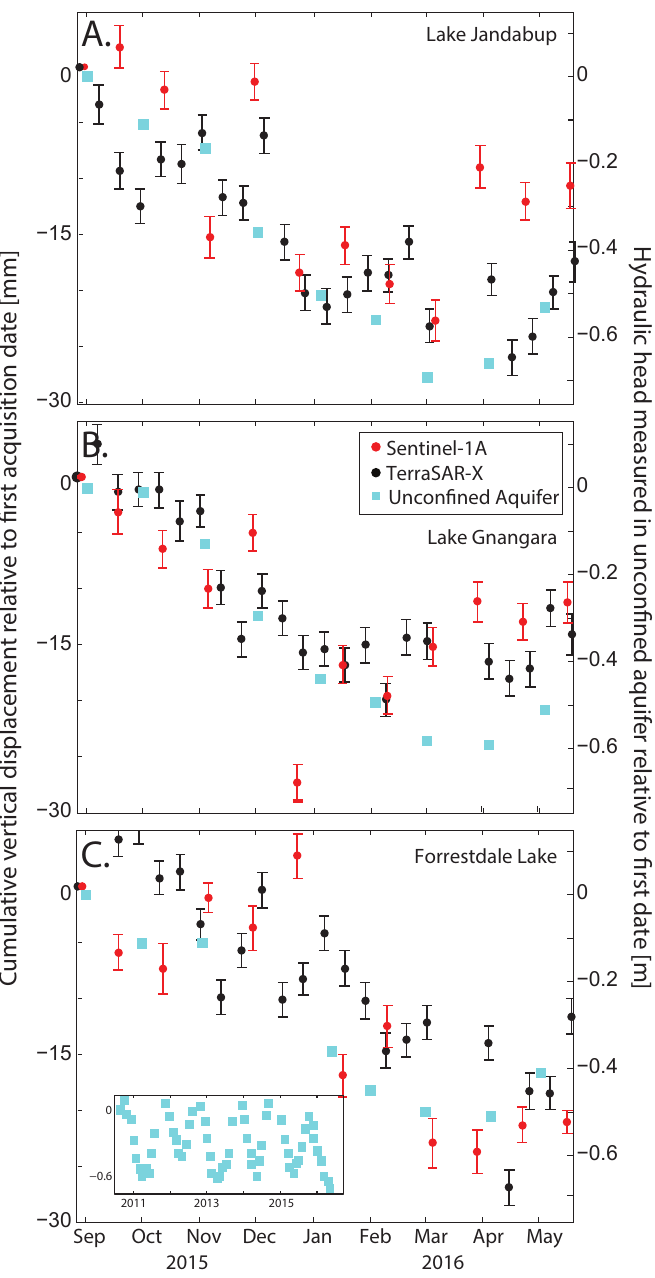
Figure 6. Time series of cumulative vertical displacement for the three regions of localised subsidence coincident with wetlands identified in Figure 4: ( A ) Lake Jandabup, ( B ) Lake Gnangara and ( C ) Forrestdale Lake. Measurements of hydraulic head are obtained from the Western Australian Department of Water as described in Section 3. Both hydraulic head and displacements are relative to the time of the first InSAR acquisition (27 August 2015) and end on 19 May 2016. Error bars are calculated using the method described in Section 4.4. The inset in (C) is a time series of hydraulic head measured at artesian monitoring bores proximal to Forrestdale Lake, but over a longer time period to demonstrate the longer term seasonal